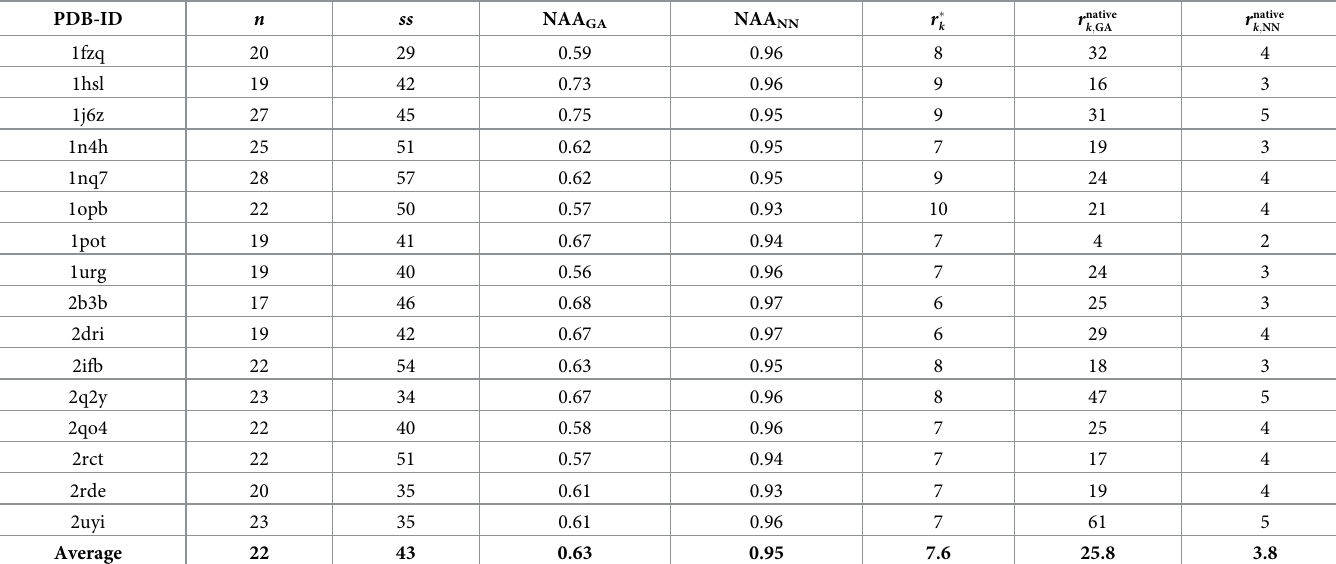
Table 1. Performance comparison of the GA- and NN-based